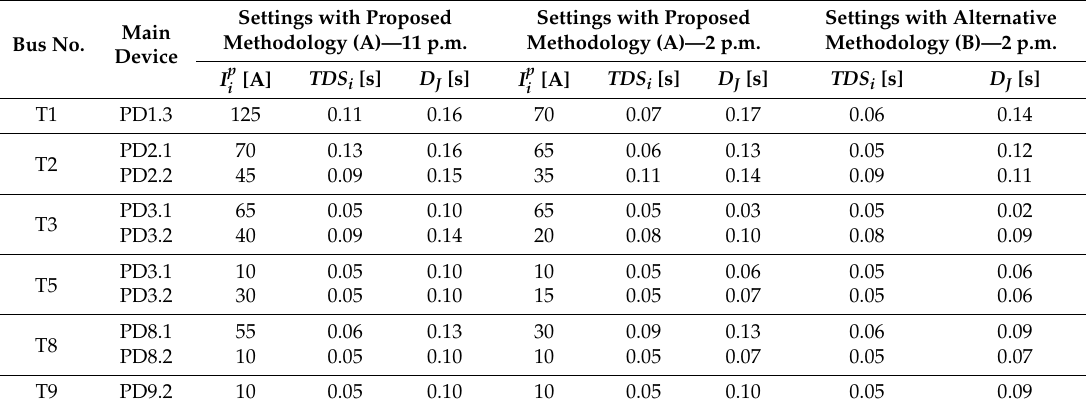
Table 3. Obtained results of ESUSCON microgrid settings in two operating conditions.